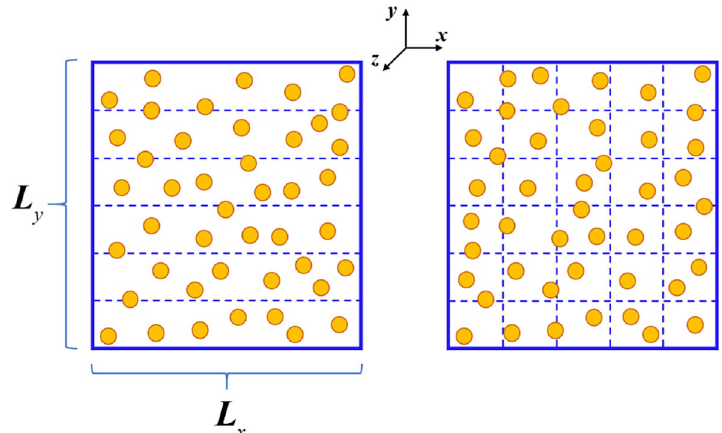
Fig. 1 Schematic diagram of DSMC simulations for 1D (left) and 2D (right) turbulence. The simulation y domain is displayed in the x −